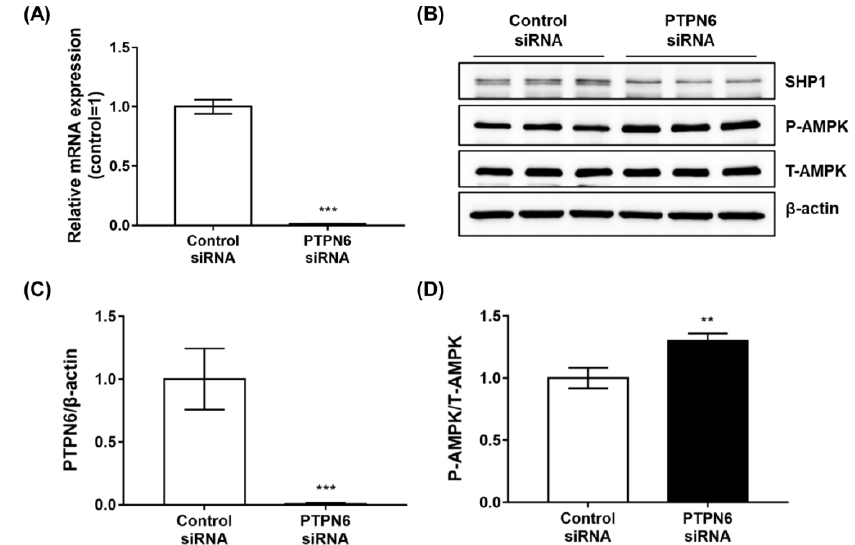
Figure 1. The depletion of PTPN6 by siRNA knockdown increases AMPK phosphorylation. 3T3-L1 preadipocytes were transfected with PTPN6 siRNA for 48 h. After cell lysis, the expression of PTPN6 was analyzed by quantitative real-time-polymerase chain reaction (qRT-PCR) ( A ) and Western blotting ( B , C ). Changes in the phosphorylation of AMPK following the knockdown of PTPN6 (also named SHP1) were analyzed by Western blotting ( B ). Quantification was performed and normalized to control using CSAnalyzer 4 ( C , D ). Data are shown as mean ± standard deviation ( n = 3). ** p < 0.01, *** p < 0.001. Statistical significance was analyzed by a two ‐ tailed unpaired t ‐ test.